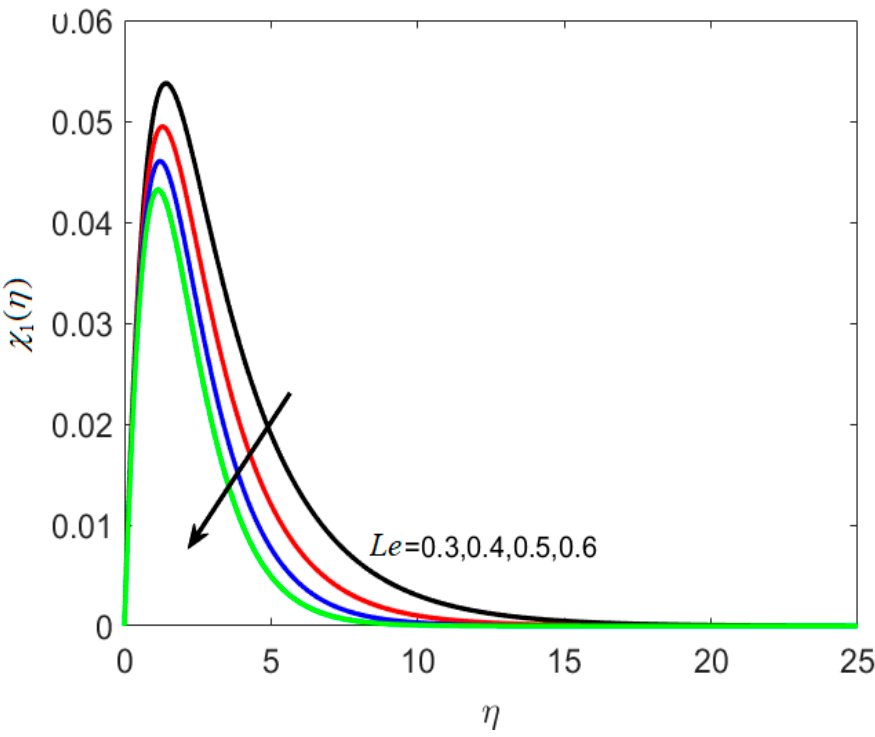
Figure 9. Various estimates of thermophoretic coefficient κ ∗ by taking B 1 = 1.3, B 2 = 1.2, S t = 0.3, λ h = 0.1, N t = 0.3, N c = 0.3, γ = 0.2, Le = 0.2, δ = 0.3.